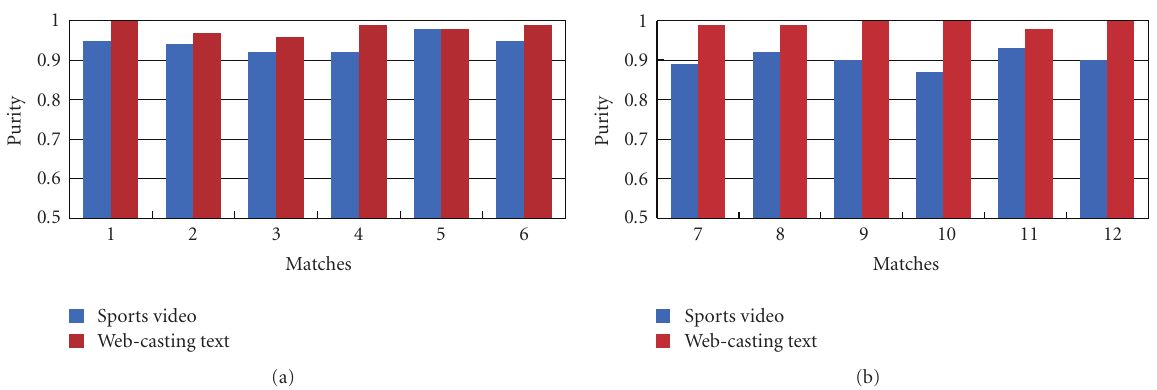
Figure 9: Attack-based sports video and web-casting text segmentation result in (a) basketball and (b) football matches. In both figures, the horizontal axes denote the match ID and the vertical axes represent the purity value of the segmentation result.